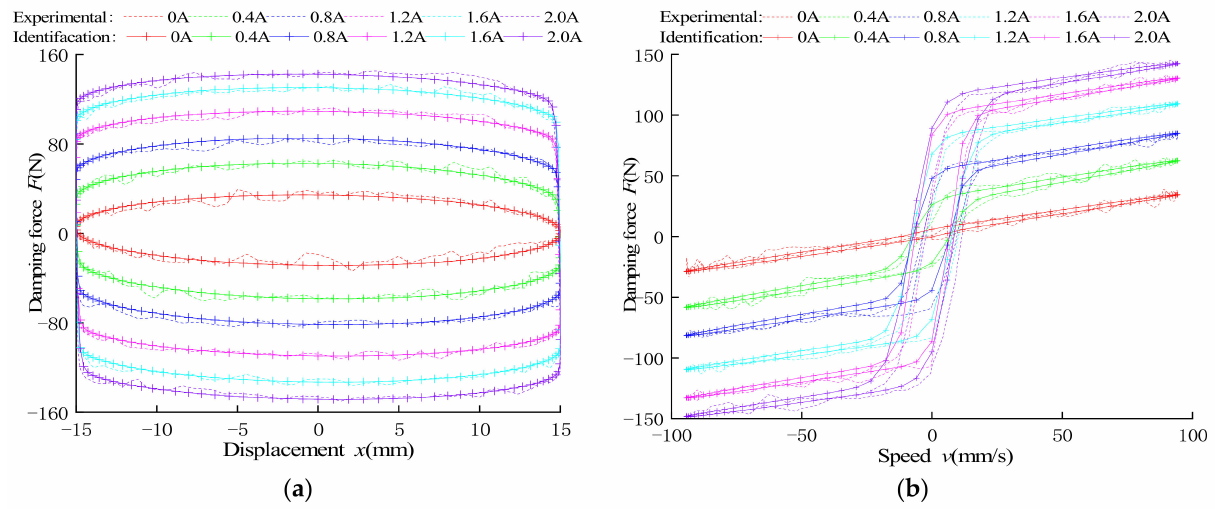
Figure 12. Comparison of dynamic performance of proposed MR damper: ( a ) damping force-displacement, ( b ) damping force-speed.